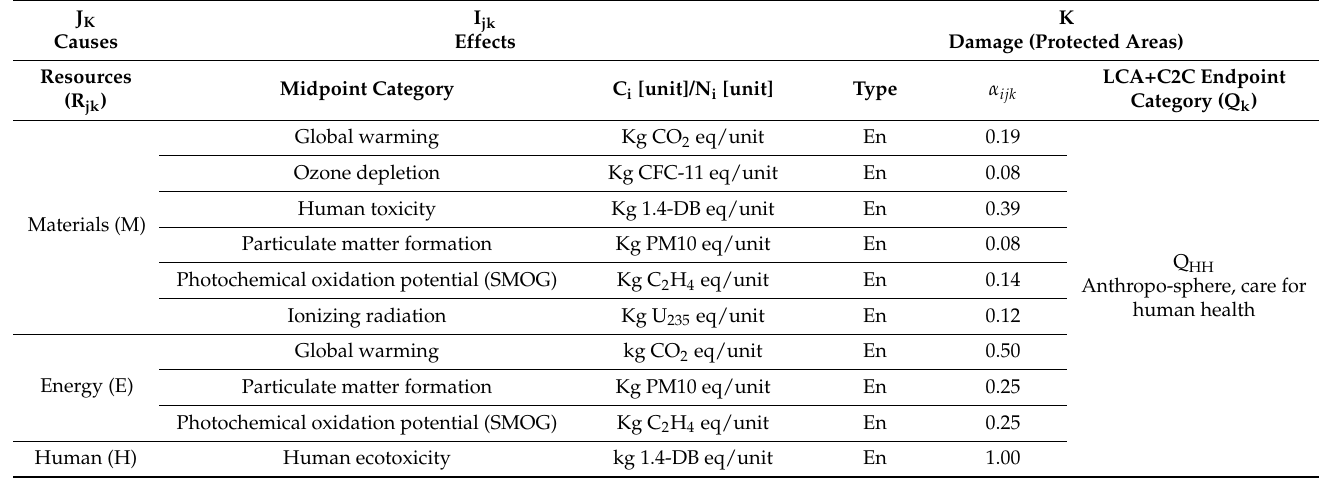
Table 2. Data, relationships and indicators for impact category